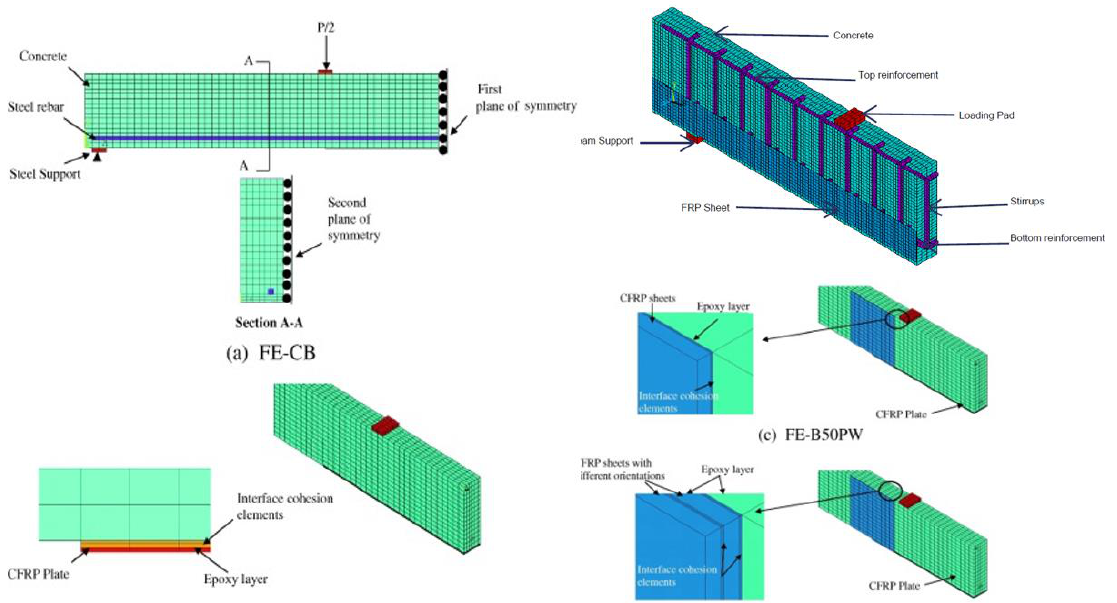
Figure 1. Typical finite element (FE) models developed in ANSYS for fiber-reinforced polymer (FRP)-strengthened Rein- forced Concrete Beams (RC beams) showing different components.